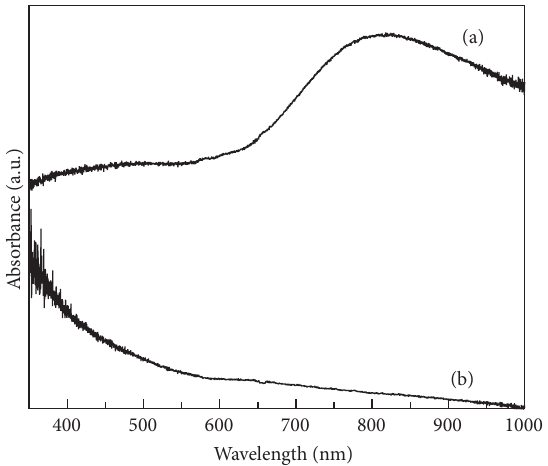
Figure 3: UV-Vis spectrum of (a) EDTA solution, (b) ionic solution of copper, and (c) EDTA-copper chelate.